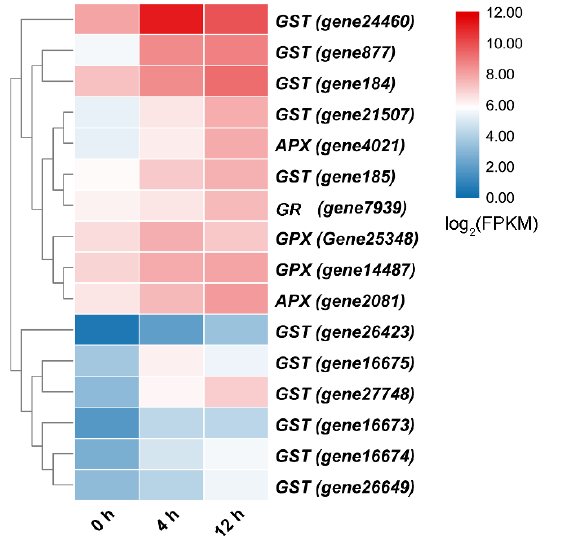
Figure 7. Heat map analysis of upregulated gene expression associated with the ascorbate-gluta- thione (AsA-GSH) cycle under salt treatment.